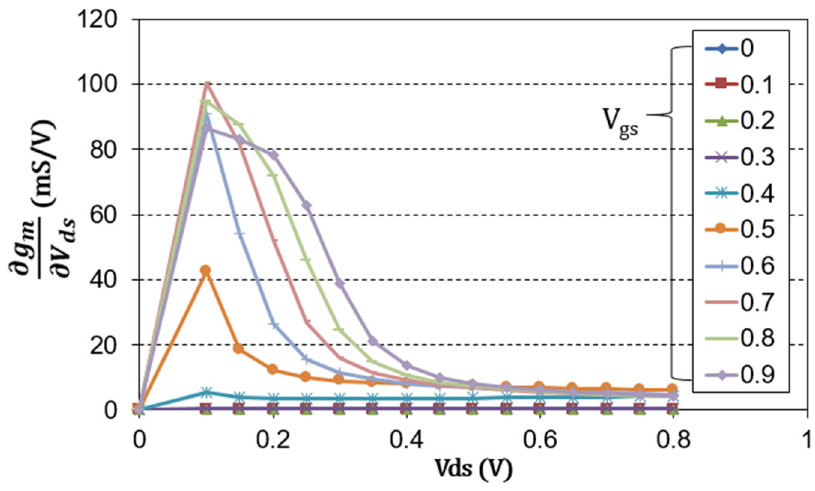
Figure 3. Simulated derivative of g m with respect to V ds according to V gs and V ds .